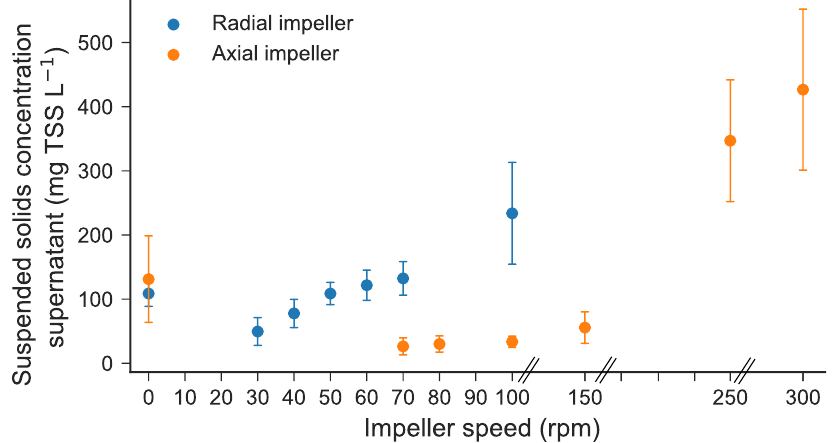
Figure 6. The results of the dispersed suspended solids (DSS) tests (represented by the suspended solids (SS) concentrations at 0 rpm) and the jar tests, with either the radial or axial impeller and for different rpms. The SS concentrations show the averaged value based on five repetitions. The error bars represent the standard deviations. The mixed liquor suspended solids (MLSS) concentration of the raw sludge samples was 4.00 ± 0.73 gTSSL − 1